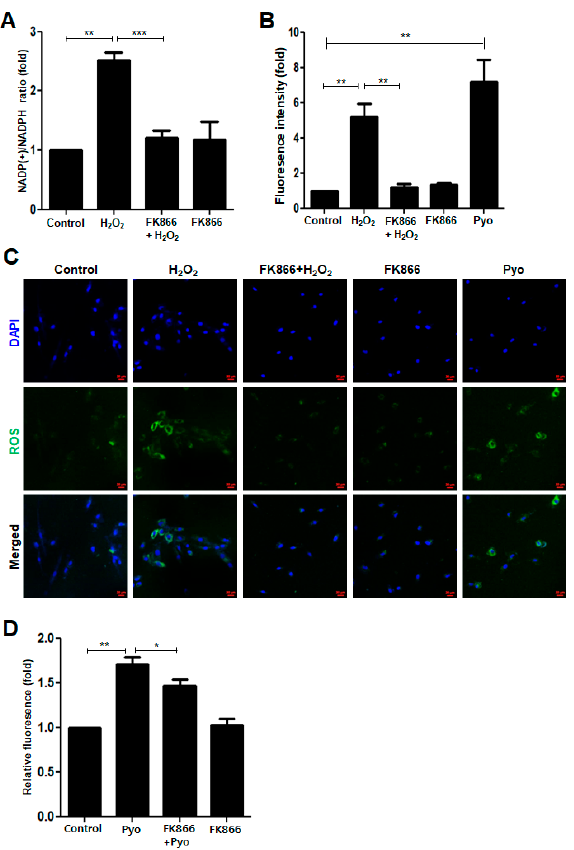
Figure 3. Effect of FK866 on H 2 O 2 -induced NADPH consumption and ROS production in hDPCs. ( A – C ) The hDPCs were pretreated with or without FK866 (10 µ M) for 2 h and then stimulated with H 2 O 2 (400 nM) for 24 h or pyocyanin (250 µ M) for 30 min. Measurement of the NADP(+)/NADPH ratio in H 2 O 2 -treated hDPCs with or without FK866 pretreatment ( A ). Measurement of the total intracellular ROS levels in H 2 O 2 -treated hDPCs with or without FK866 pretreatment using a fluores- cent microplate reader ( B ) and a confocal microscope ( C ). Pyocyanin, a redox-active compound that generates ROS, was used as a positive control for ROS production. The nuclei were counterstained with DAPI (blue). Scale bar: 20 µ m. ( D ) The hDPCs were pretreated with FK866 (10 µ M) for 2 h and then stimulated with pyocyanin (Pyo) for 30 min. * p < 0.1, ** p < 0.01, *** p <